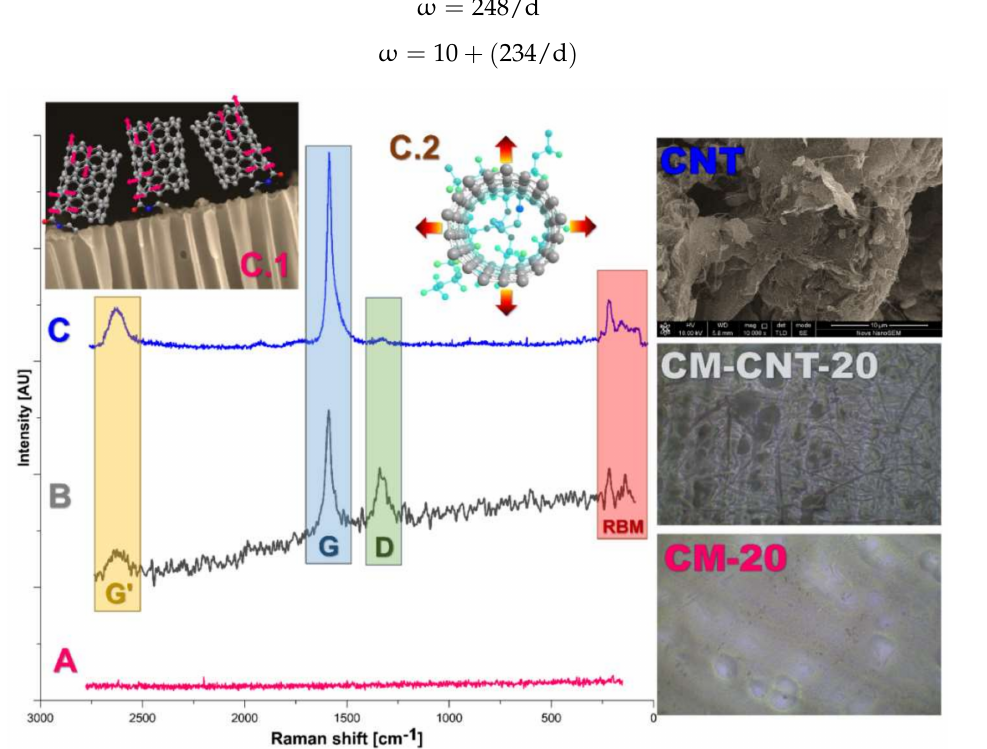
Figure 5. Raman spectra of pristine (CM-20) ( A ) and modified (CM-CNT-20) ( B ) membranes and pure single-wall carbon nanotubes (SWCNTs) ( C ): ( C.1 ) G-band explanation consists of G + (vibrations along the nanotube axis—longitudinal optical phonon mode) and G − (vibrations along the circumferential direction of the nanotube—transverse optical phonon mode); ( C.2 ) radial breathing mode (RBM)